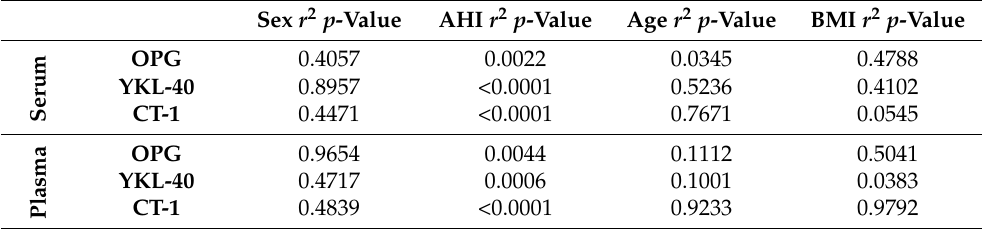
The values of r with p < 0.05 were considered statistically significant. The multiple linear regression models for serum and plasma OPG, YKL-40, and CT-1 use sex, AHI, age, and BMI as estimates. Abbreviations: OSA, Obstructive Sleep Apnea; OPG, Osteoprotegerin; YKL-40, Chitinase-3 like protein-1; CT-1, Cardiotrophin-1; AHI, Apnea–Hypopnea Index; BMI, Body Mass